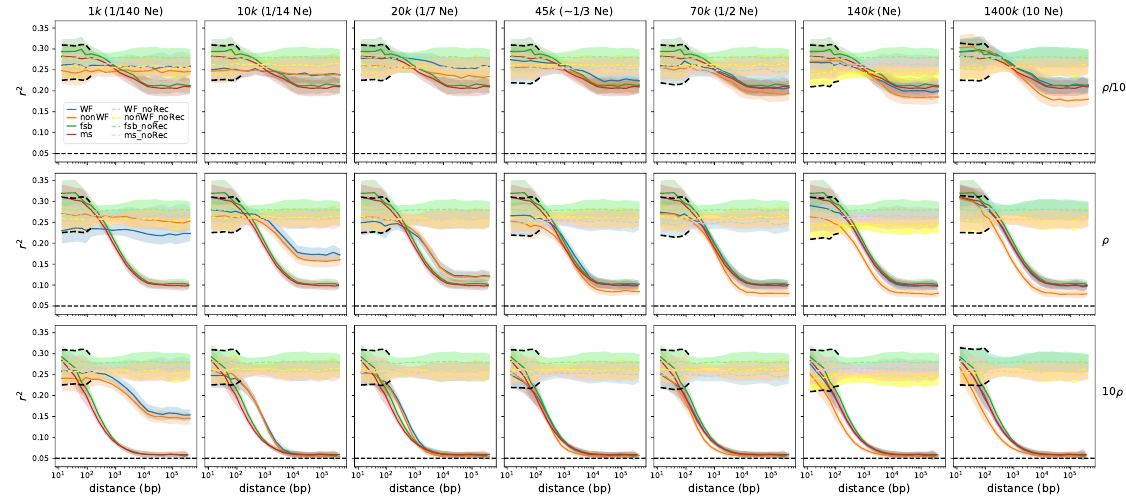
2 with free recombination when